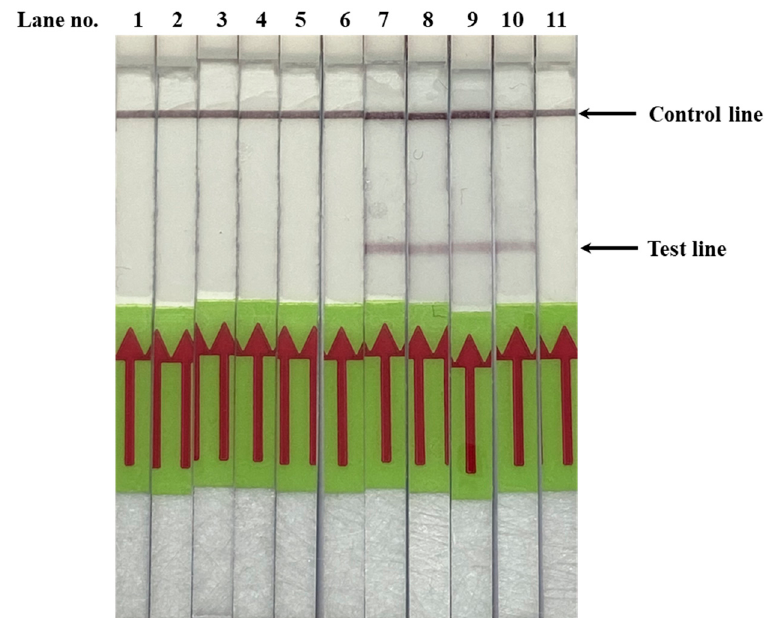
Figure 3. Representative results for SNP-loop-mediated isothermal amplification combined with later flow dipstick ( Pf SNP-LAMP-LFD) assay. The products from Pf SNP-LAMP reactions were hybridized with labelled probes and applied to the LFD strips for visualization. Lane 1 was a negative control (no DNA template). Lanes 2–6 were pUC18- Pfdhfr -TM4/8.2 (wild-type SNP) diluted at 20 ng, 2 ng, 0.2 ng, 0.02 ng and 0.002 ng, respectively. Lanes 7–11 were pUC18- Pfdhfr -V1/S (mutant SNP) diluted at 20 ng, 2 ng, 0.2 ng, 0.02 ng, and 0.002 ng, respectively. For positive detection of the SNP mutation, both the control and test lines must appear on the strip. For wild-type SNP, only the control line appears. If no signal appears on the control line, then the result is invalid.